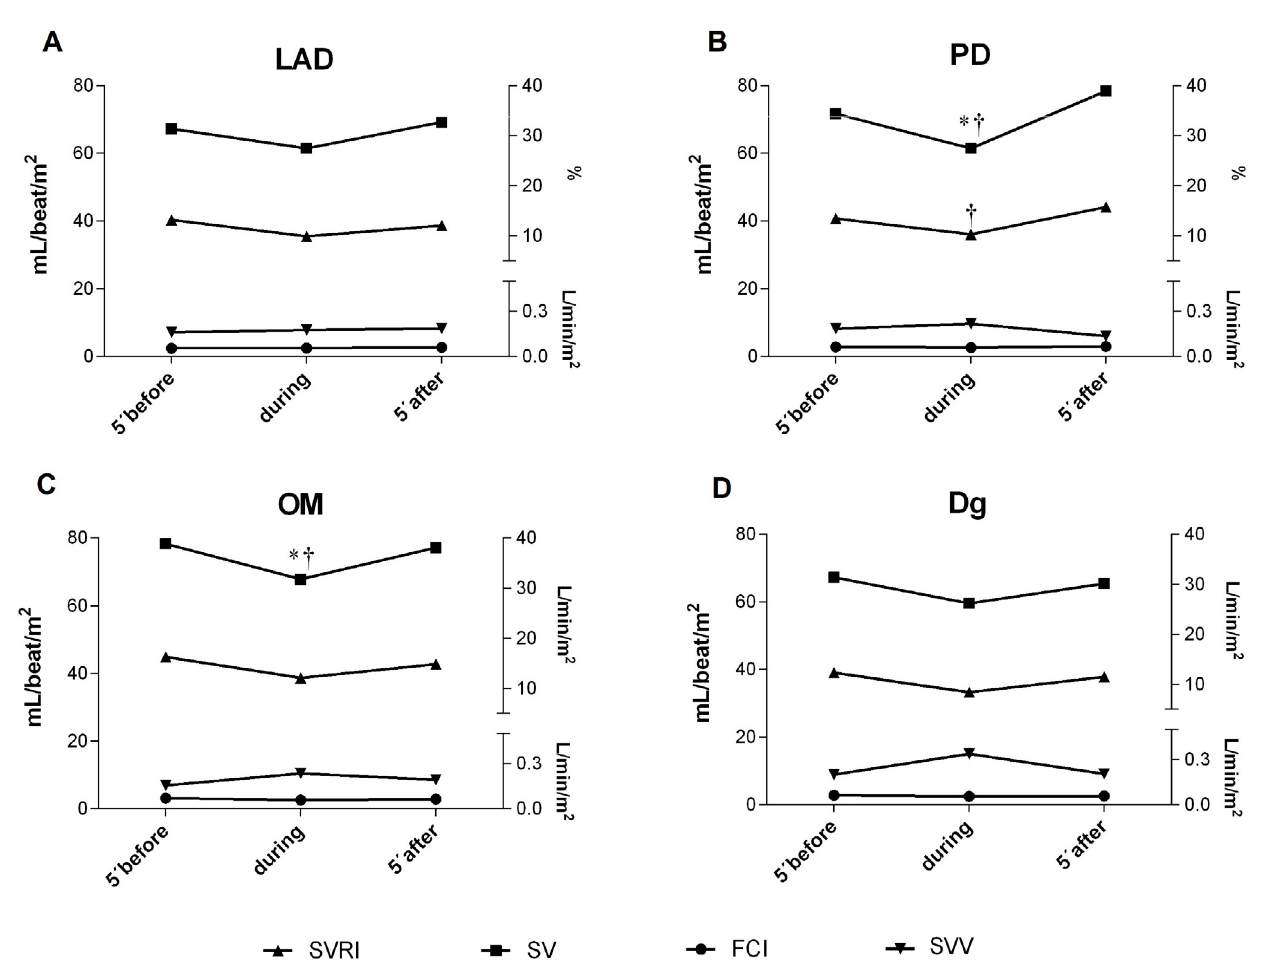
Fig. 3 – Hemodynamic responses during coronary artery bypass graft anastomosis. Dg=diagonal; FCI=continuous cardiac index; LAD=left anterior descending; OM=Obtuse marginal; PD=posterior descending; SV=stroke volume; SVRI=systemic vascular resistance index; SVV=stroke volume